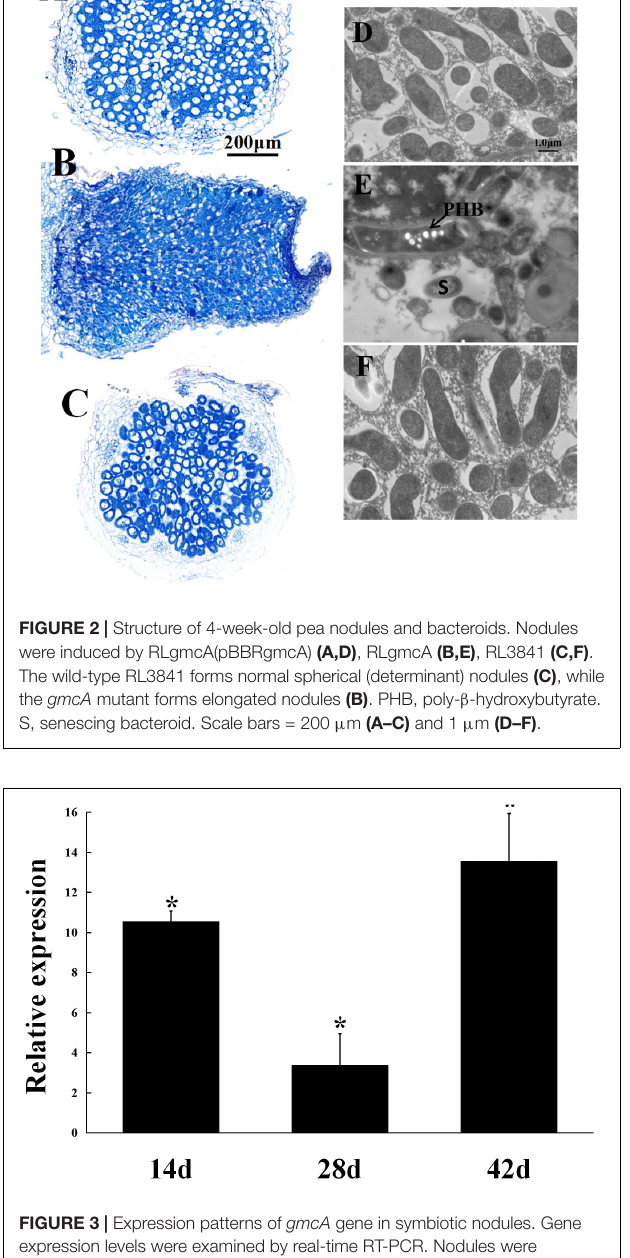
space, five proteins located in the outer membrane, two were extracellular proteins, and one protein existed in the inner membrane ( Table 5 ).